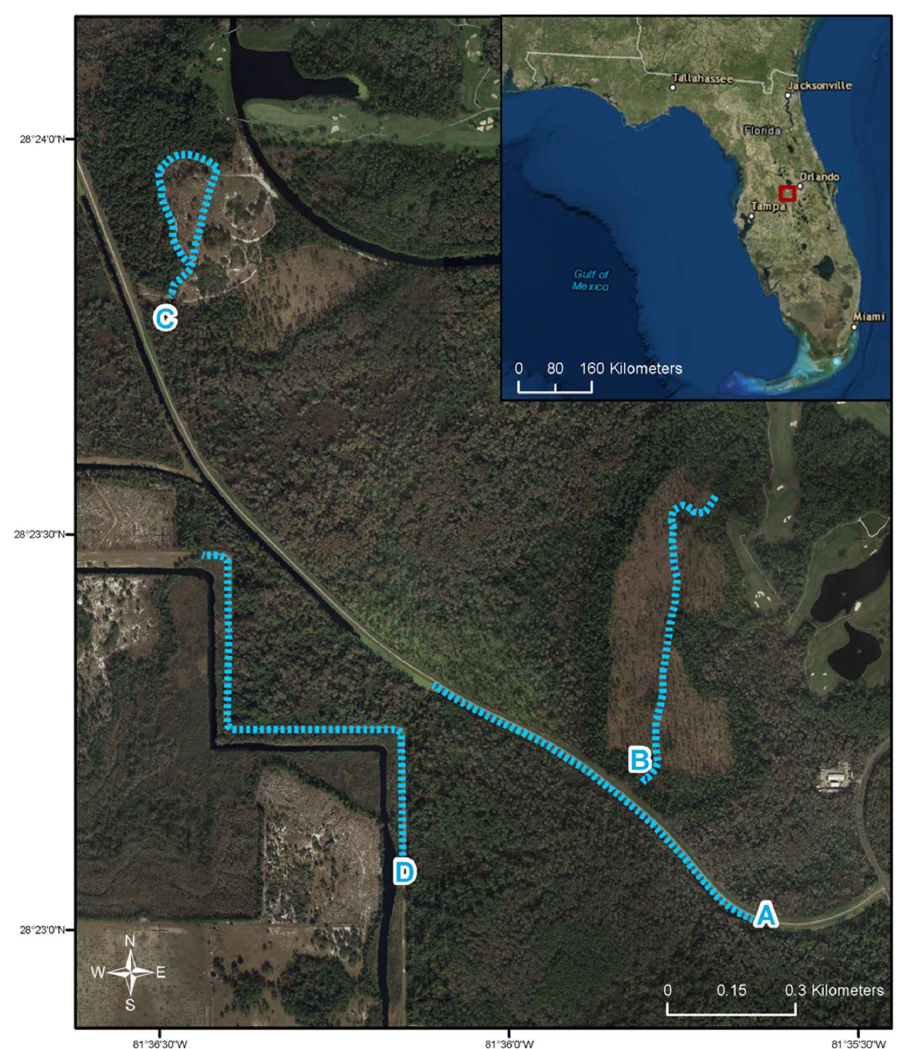
Figure 1. Site map of the study area within Walt Disney World Resort ® ’s Wildlife Management and Conservation Area, showing the four sampling routes used throughout this